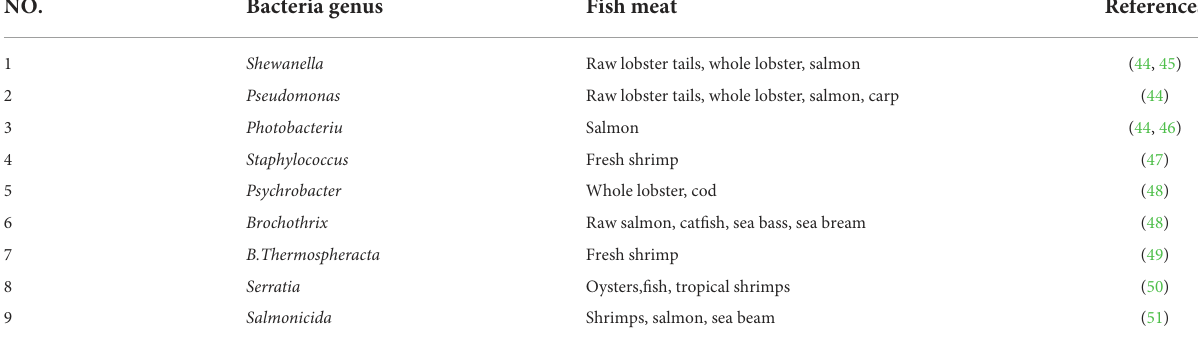
TABLE 2 List of bacterial groups associated with fish meat